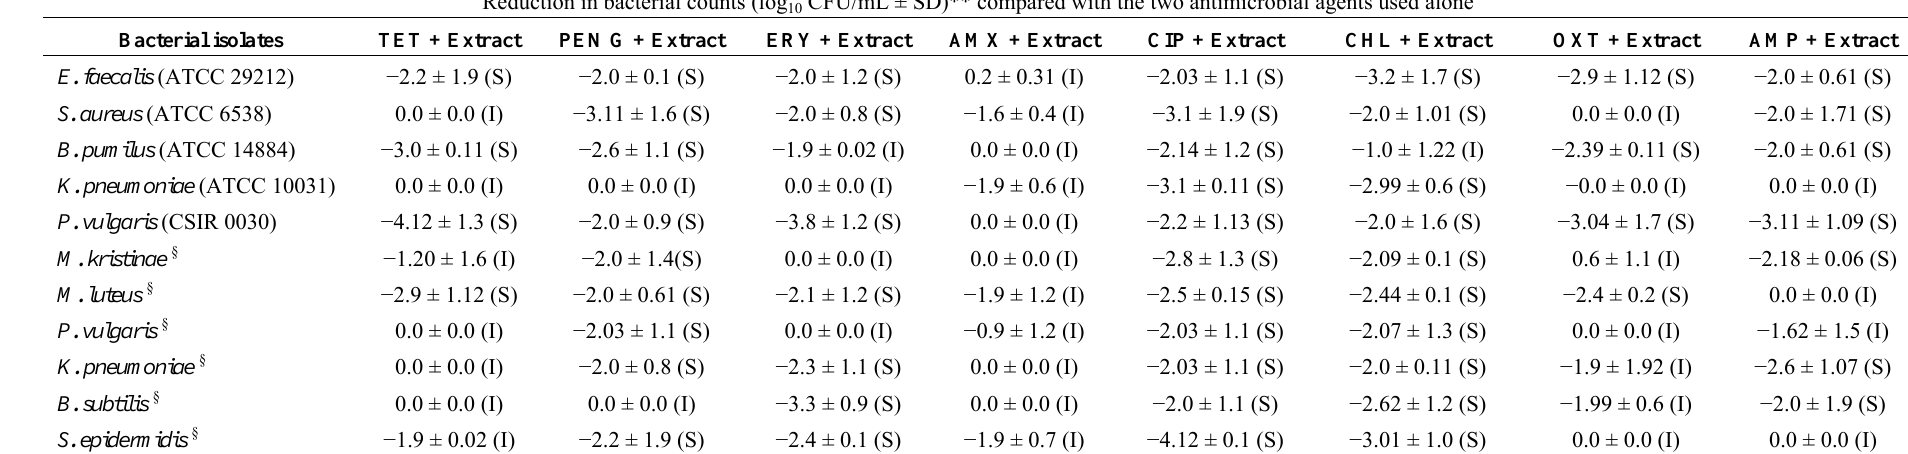
Table 4. In vitro activity of Extract-Antibiotic combination at ½ × MIC level against test bacterial